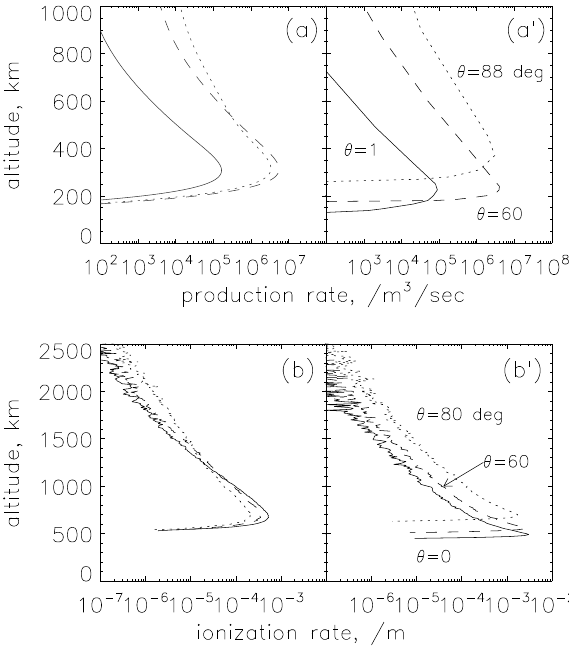
Figure 8: 2007.12.18: Y. Hiraki and C. Tao Figure 9: 2007.12.18: Y. Hiraki and C. Tao Fig. 8. (a) Comparison of an ion production rate q ion F by our pa- Fig. 9. Comparison of our ionization rates (a) with the excitation rameterization (solid) with the previously presented value by Gro- rate (a’) by Prang ´ e et al. (1995); in both the incident angles of elec- dent et al. (2001) (dotted), F the electron flux. (b) Comparison of trons are 1 (solid-line), 60 (dashed), and 88 (dotted) degrees, and our parameterized ionization rates with that (dotted line) by Rego the energy flux is 1 erg/cm 2 /s/(2 π sr). (b’) shows test results where et al. (1994). Solid (dashed) line represents the rate produced based the moving direction of both the primary and secondary electrons on the H + H 2 (pure H 2 ) density distribution and electron energy is fixed as θ all through the calculation; (b) shows our results with spectrum they adopted (see text for details). no assumption; these line types are for the same incident angles as those in